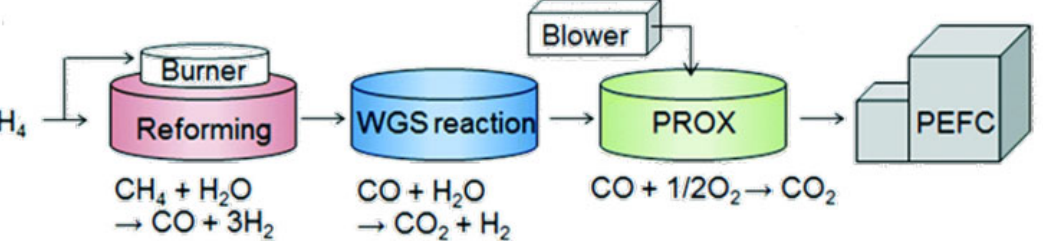
Figure 3. Catalytic processes used sequentially to obtain high-purity hydrogen for PEFC systems, where WGS represents water–gas shift reaction, PROX indicates preferential reaction oxidation of CO, and PEFC represents polymer electrolyte fuel cells. Reprinted with permission from Ref. [12]. Copyright 2015 Royal Society of Chemistry.